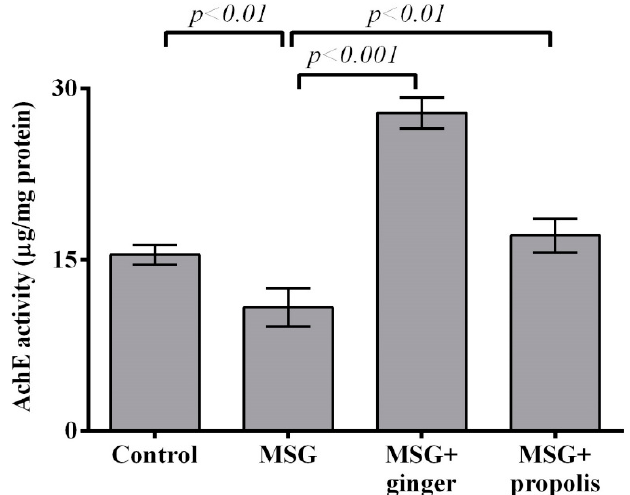
Figure 12. Cerebral cortex acetylcholinesterase (AchE) activity at two months post-treatment. Data are expressed as mean ± SEM ( n = 6). Comparisons were made between normal control and MSG control groups, and also between MSG control and MSG plus ginger or propolis supplement groups.